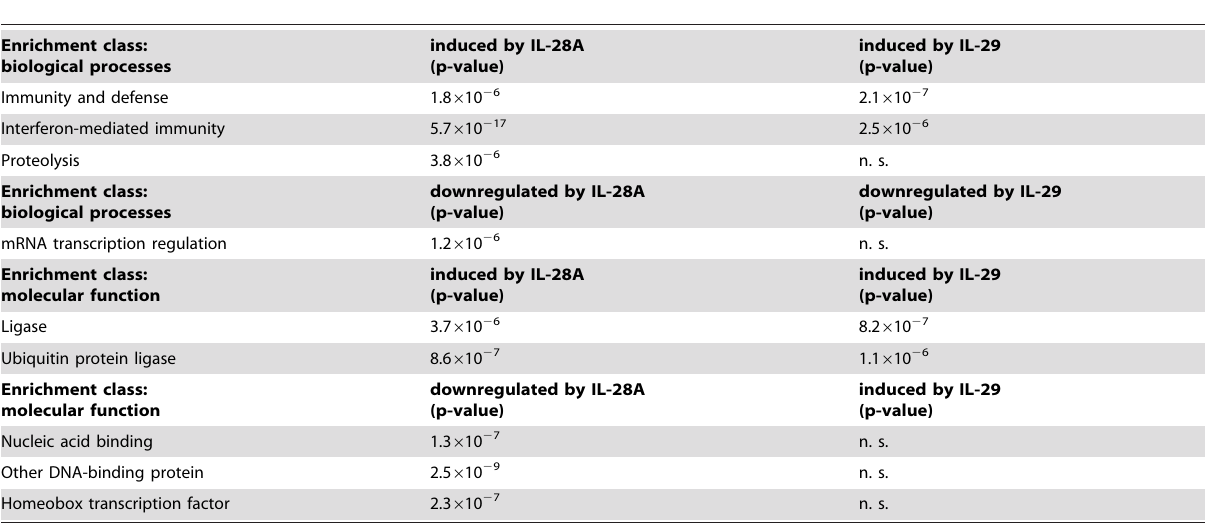
Table 5. Functional classification of IL-28A and IL-29-induced and repressed genes regarding the categories of biological processes and molecular functions applying the Panther software